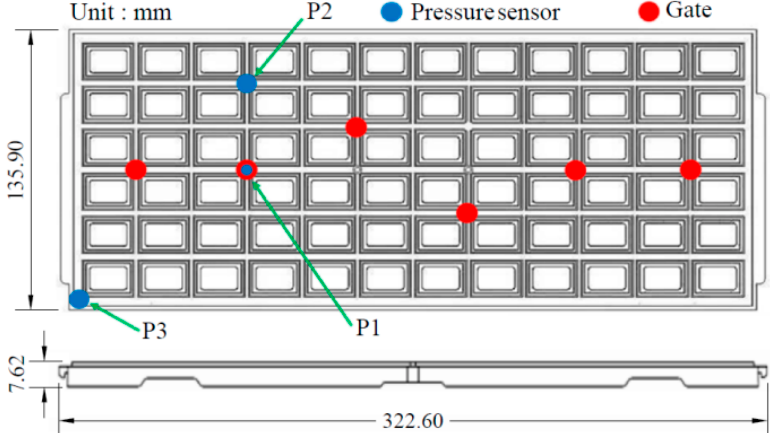
Figure 3. IC tray geometry and sensing location.